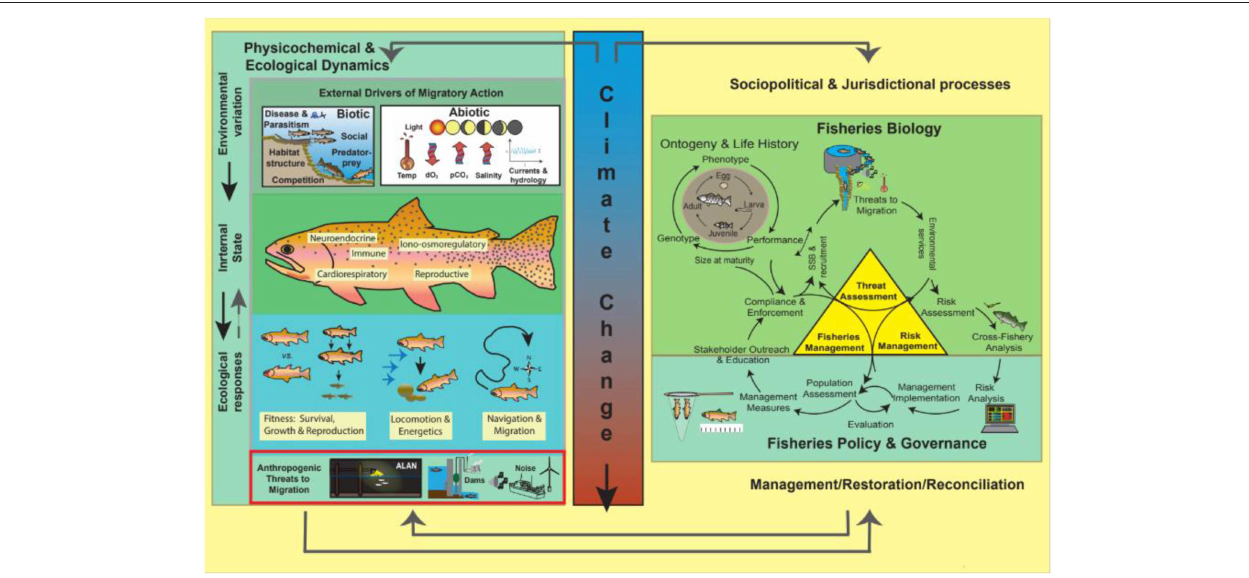
FIGURE 1 | By migrating, a fish uses multiple habitats for growth, refuge and reproduction. External drivers such as lunar and solar cues and temperature are integrated by fish sensory systems and can shift the internal state, stimulating migration. Fish use multiple physiological sensory systems to navigate and arrive at the right place at the right time and conserve energy with efficient locomotion. Many migratory fish taxa are threatened by human infrastructure and land use modification, which can interact with threats posed by climate change. In the right-hand panel, we see how sociopolitical and jurisdictional processes can affect the environmental aspects of migration. Threats to migratory fish are managed, often through fisheries management, and risks are managed with other institutions such as marine protected areas. Rapid environmental change from climate change or human activities affect the relationship between cues and environmental conditions, which mismatches migratory timing and energy budgets and can threaten the viability of migration as a behavior. Governance structures and political institutions are responsible for minimizing these threats and implementing effective management actions, including habitat restoration that maintains connectivity and ensures migratory fish will persist in the future. ALAN refers to artificial light at